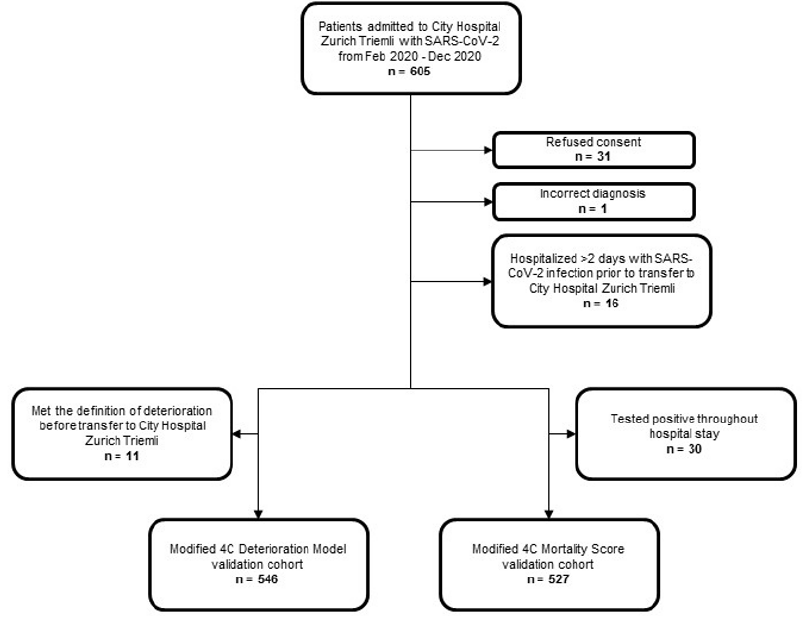
Figure 1. Study population. Table 1. Clinical and demographic characteristics of modified 4C Deterioration Model validation